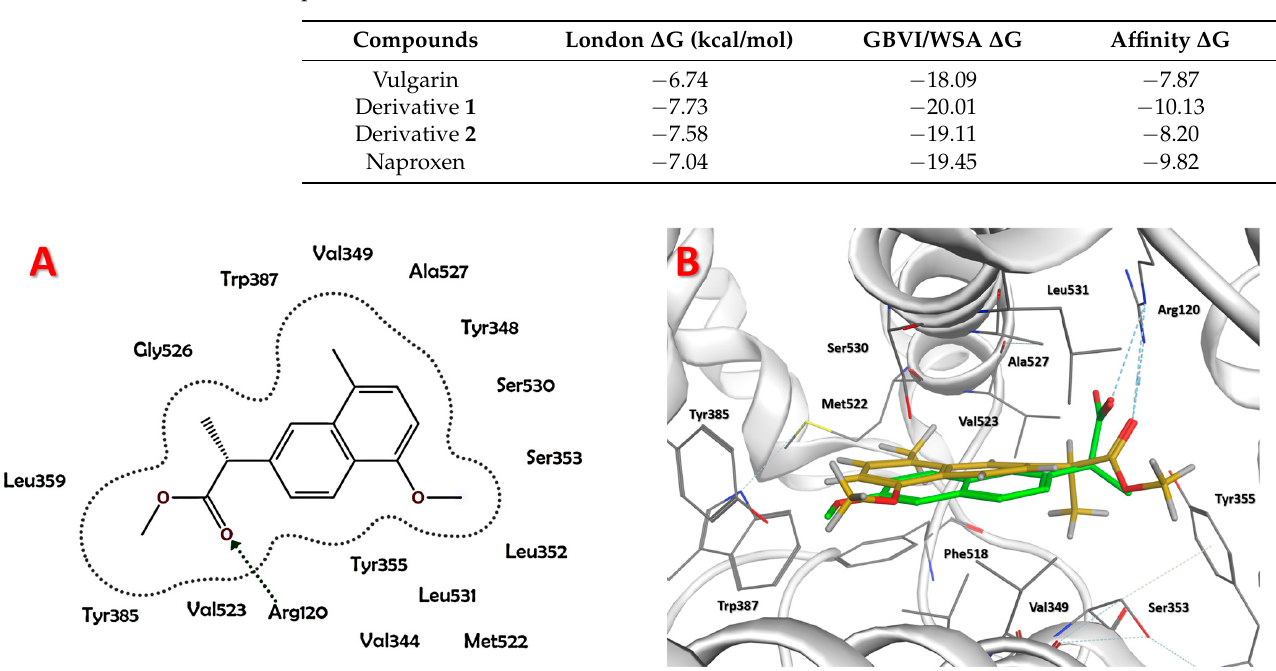
Figure 1. ( A ) 2D placement of derivative 1 inside the active site of COX-2; ( B ) similar orientation of naproxen in a 3D view (green) and derivative 1 (yellow), they are superimposed by their docking poses. Naproxen was subjected to a redocking process to evaluate its binding mode. It showed two hydrogen bonds with Arg120 and Van der Waals interactions with Ala527